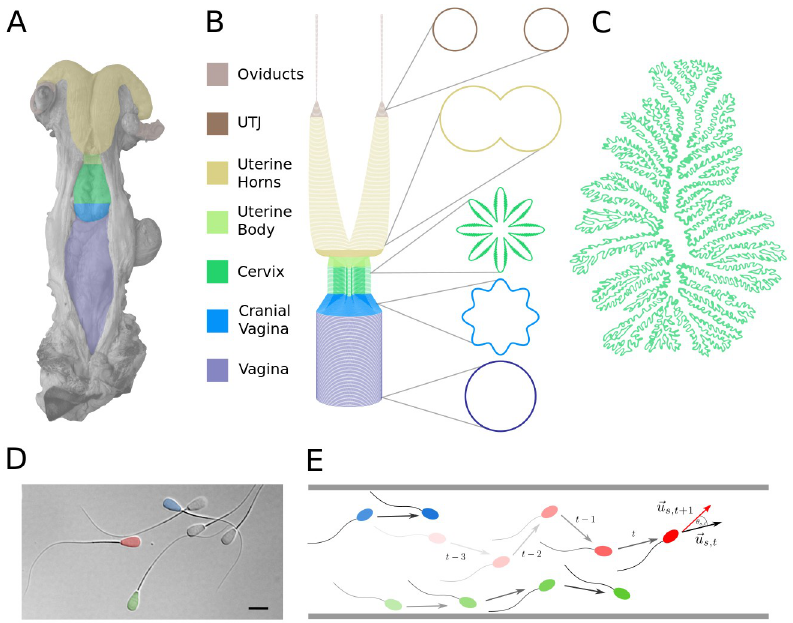
Fig 1. Mathematical representation of the female genital tract and sperm movement. A Grey-colored photograph of a bovine female genital tract. Colorcoding indicated separate compartments. The photograph was kindly provided by Dr. A. Peters IFN Scho¨now. B The genital tract is mathematically represented by three-dimensional functions sketched here together with cross-sections at different heights. C Sketch of a bovine cervical cross section, adapted from [21]. D Differential interference contrast image of bovine sperm, with colorized heads (to highlight individual differences), bar is 10 μ m. E Sperms are represented as agents with individual properties in ABM, exploring the reconstructed female